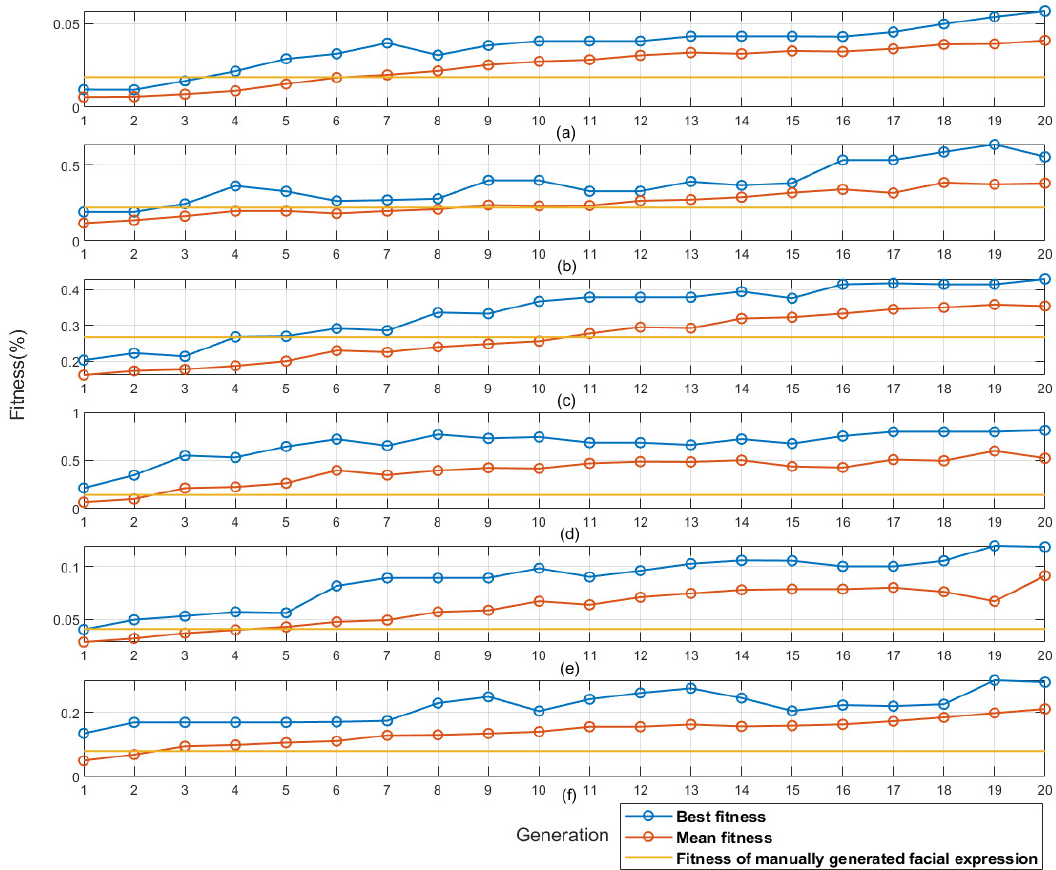
Figure 12. Comparison between fitness value of facial expressions generated by the proposed system and those generated manually in older male robot—( a ) Angry, ( b ) Disgust, ( c ) Fear, ( d ) Happy, ( e ) Sad and ( f ) Surprised.